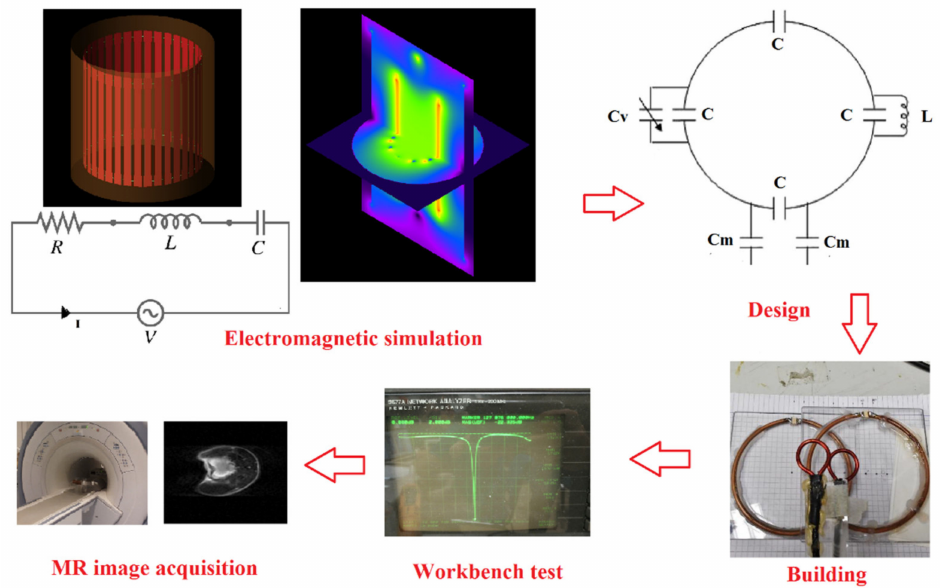
Figure 1. The different phases in the RF coil development.